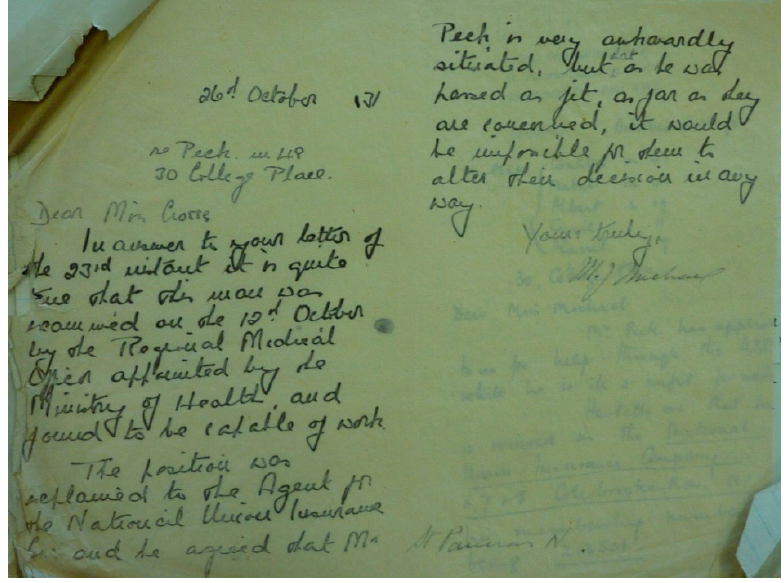
Figure 1. Letter to COS (Charity Organisation Society) confirming Mr. Peck’s fitness to work. 26 October 1931.